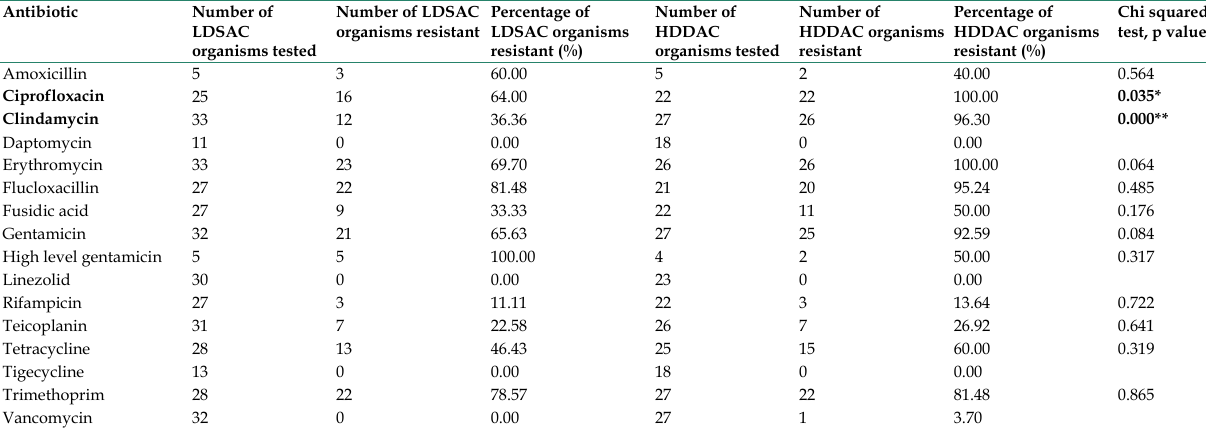
Table 2. Resistance rates in Gram positive organisms Antibiotic